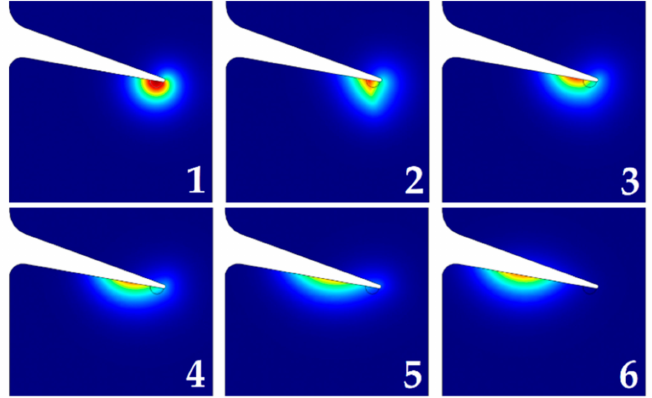
Figure 10. Simulation of a movement of “reciprocating” of a suspended